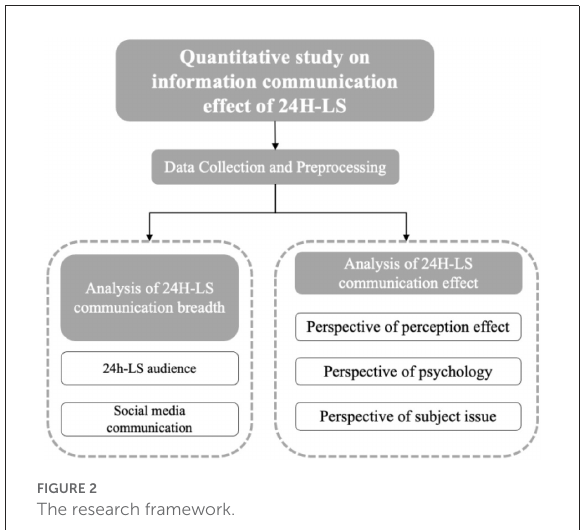
FIGURE2 The research framework.